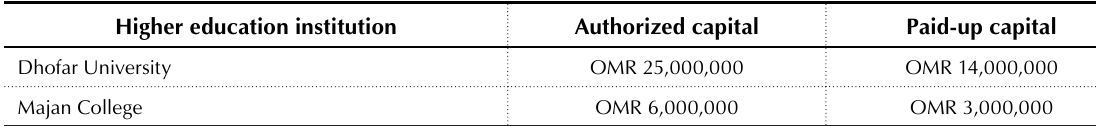
Table 2. Authorized and paid up capital